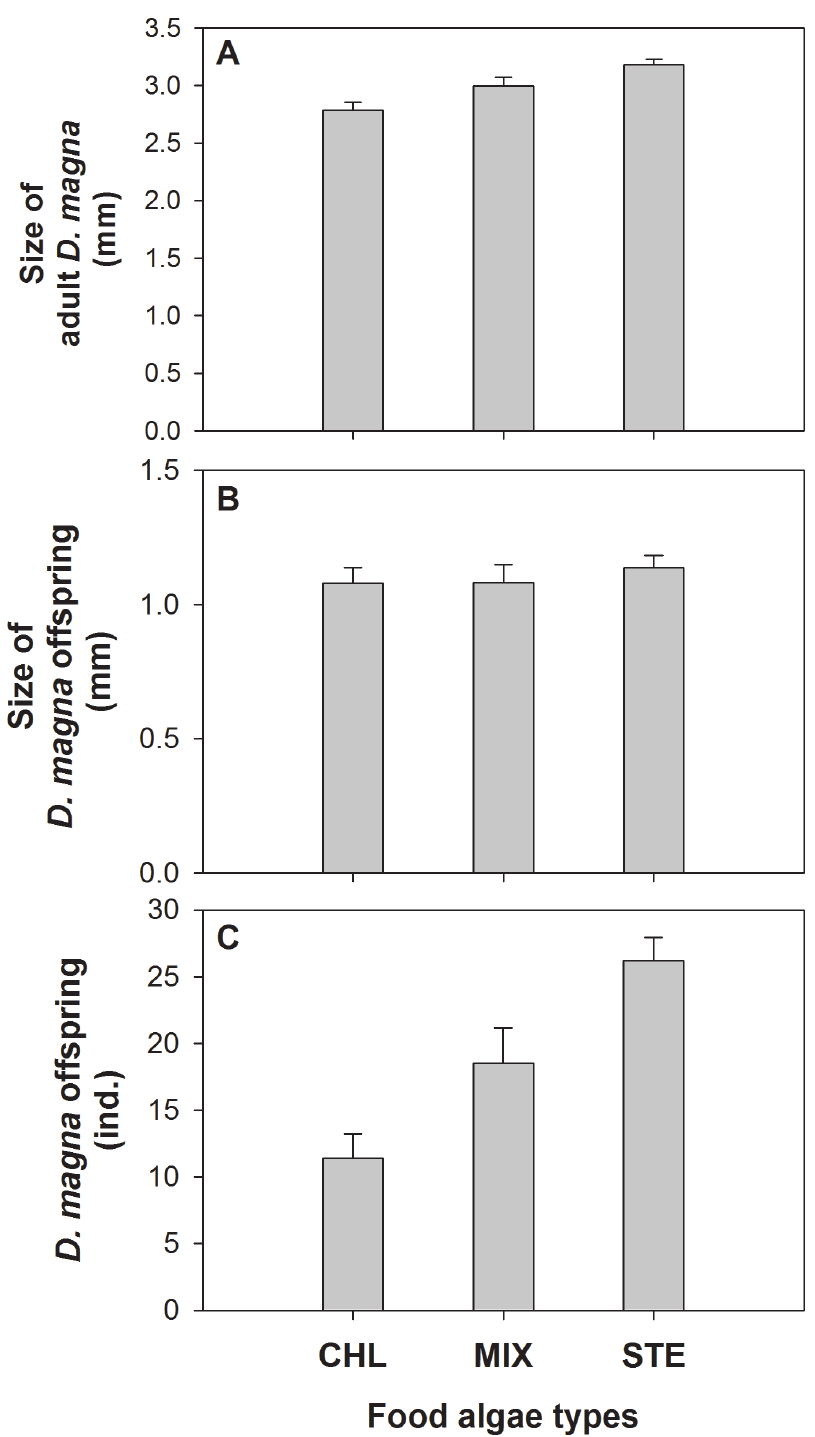
Figure 2. Size and number of individual Daphniamagna according to the prey species provided. A) size of adults; B) size of offspring; C) number of individual offspring. CHL, C. vulgaris ; STE, S. hantzschii ; MIX, a mixture of both food algal species; n =20, respectively.